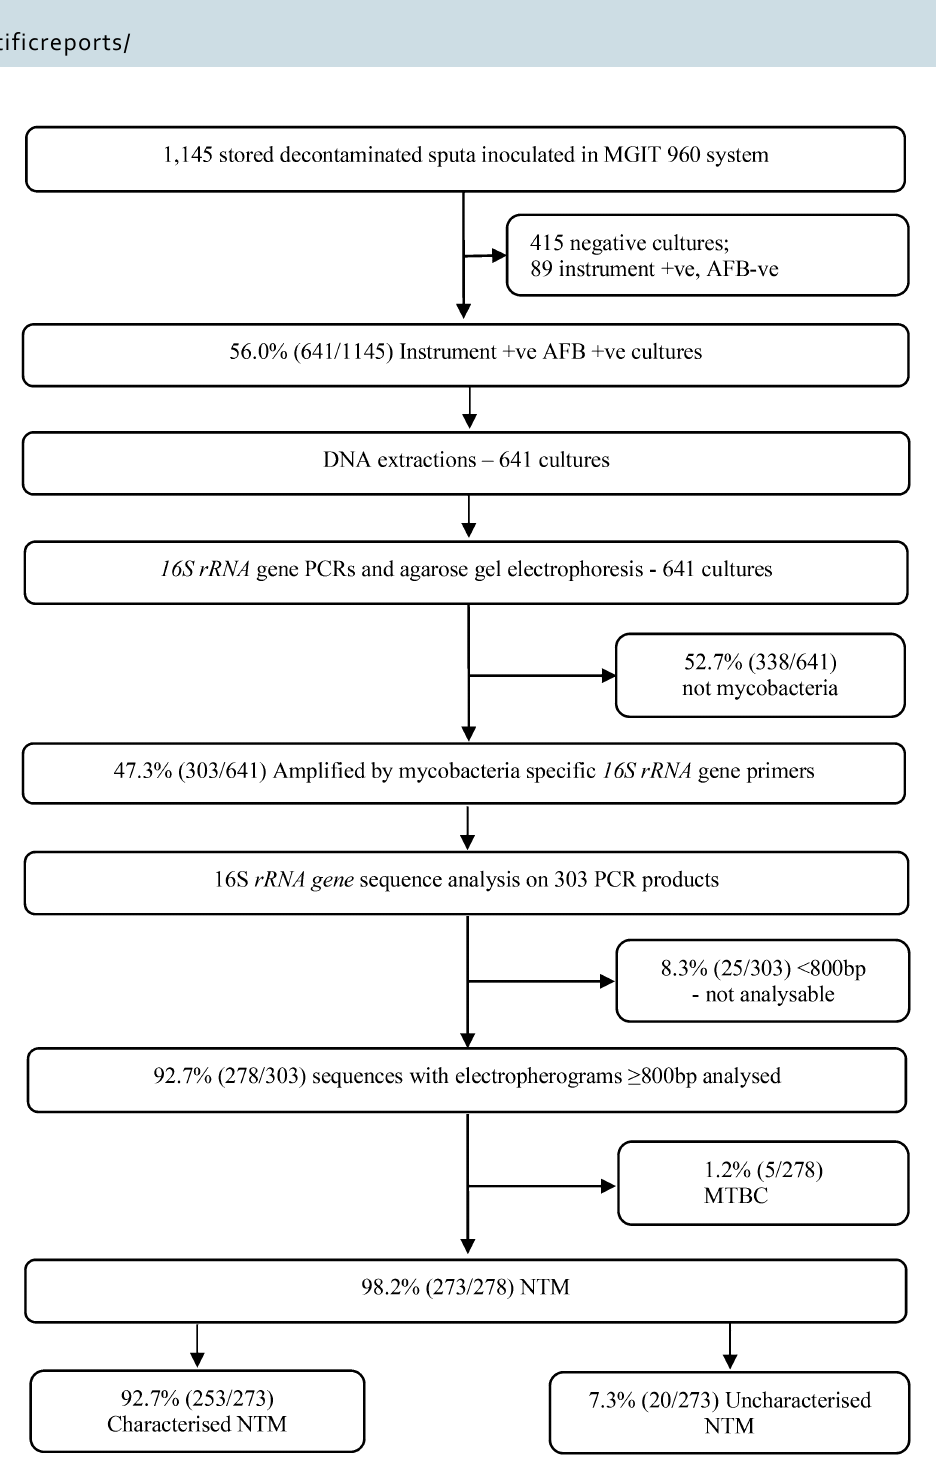
Figure 3. Culture results of non-tuberculous mycobacteria in eligible sputum samples at different stages of sample